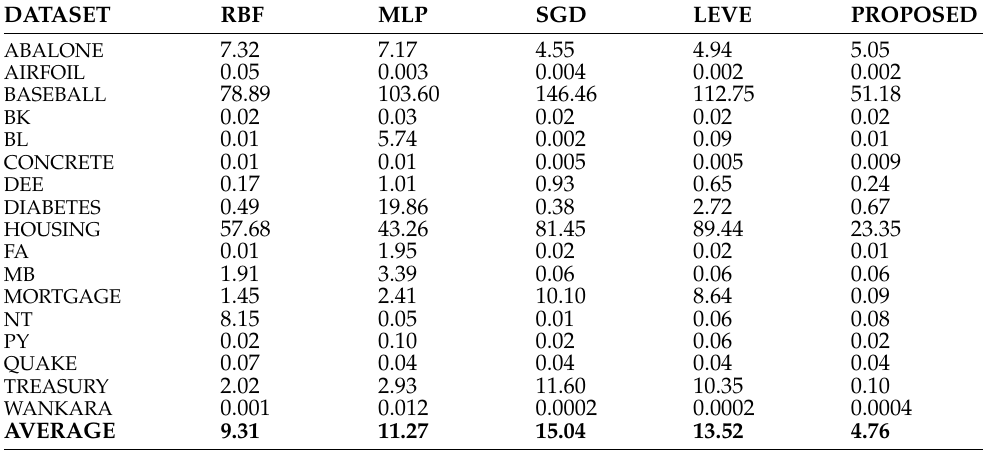
Table 3. Experiments for regression datasets.